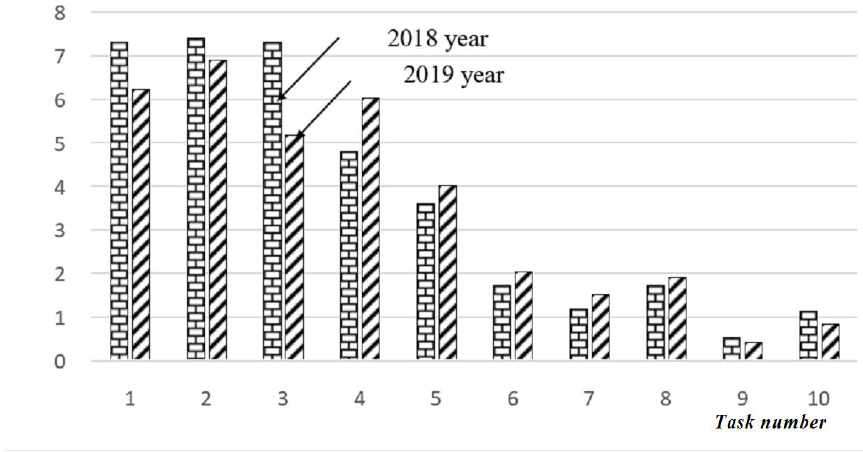
Fig. 6. Marks for the tasks of the entrance testing at the Department of Mechanical Engineering in 2018 and